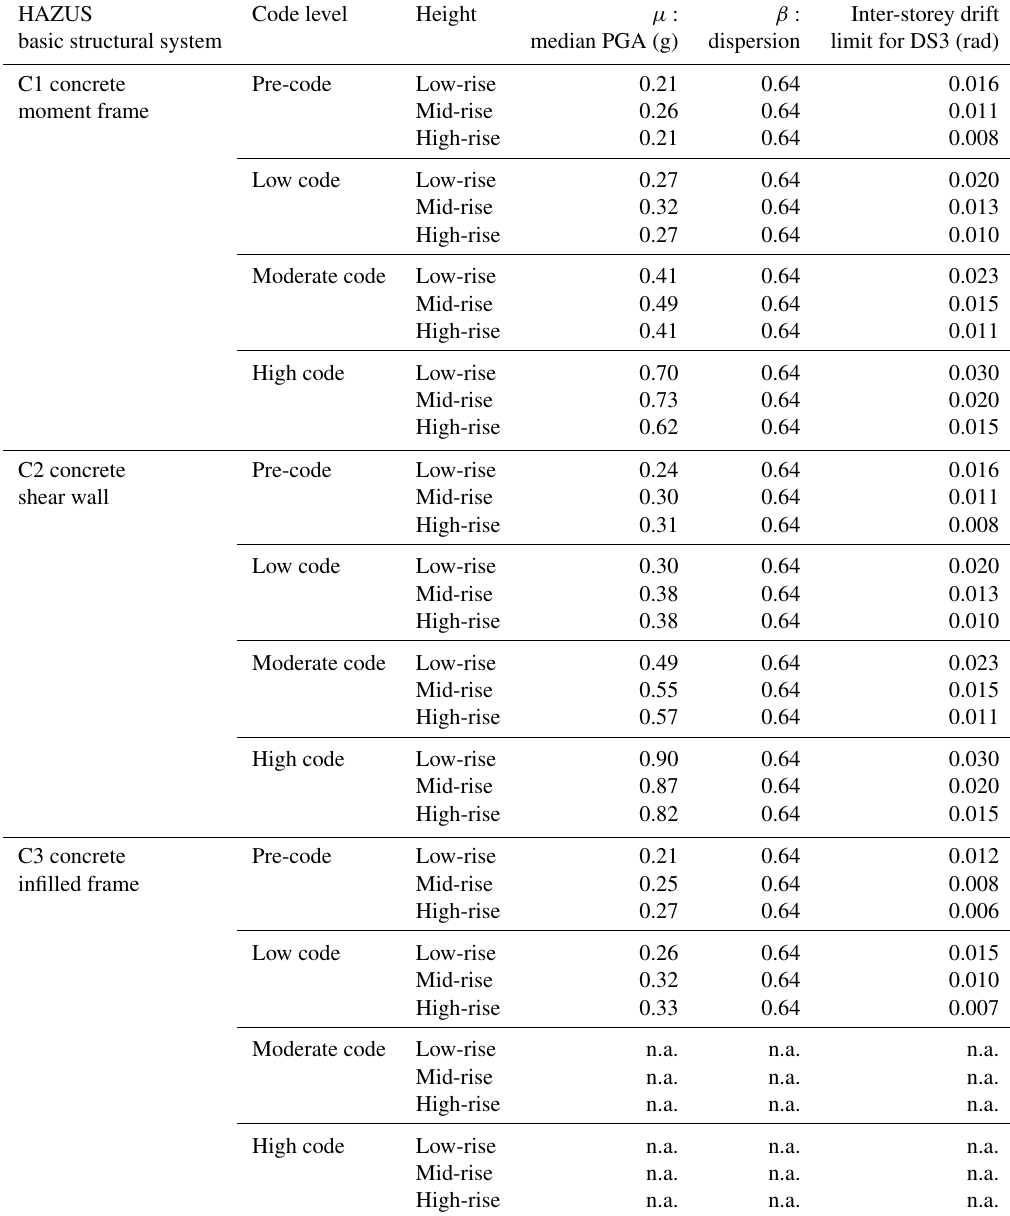
Table 1. Selected fragility curves from the HAZUS MH4 framework (Kircher et al., 2006).